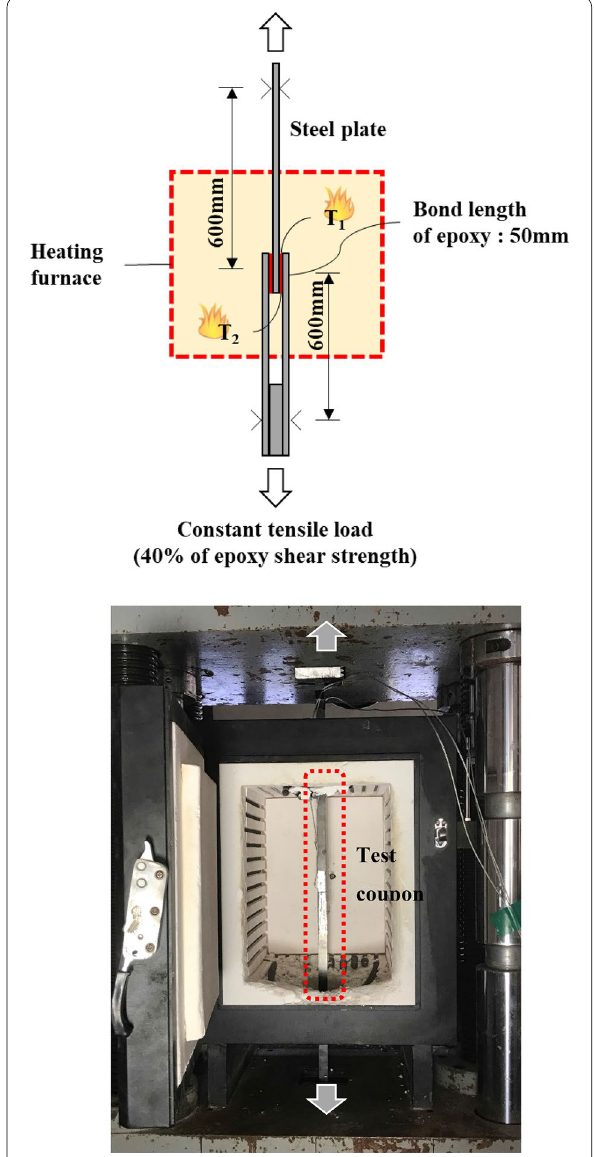
Fig. 5 Bond‑shear test of epoxy under temperature